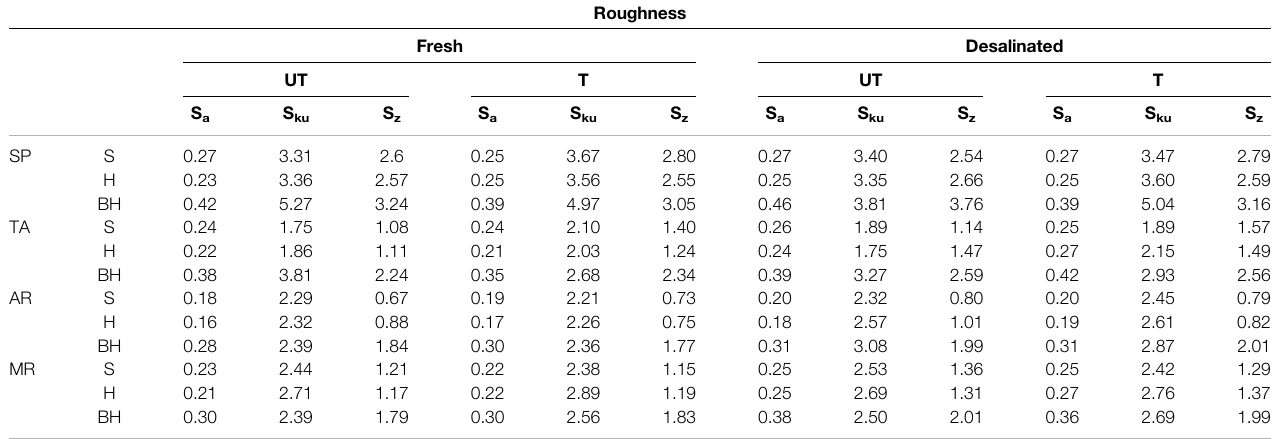
TABLE 2 | Mean roughness values for intact samples (Fresh) and for altered samples from which the gypsum crust has been removed (Desalinated), untreated (UT) and treated (T) in relation to each surface fi nish (saw-cut - S, honed - H and bush-hammered - BH) of Calcarenita de Santa Pudia (SP), Travertino Amarillo (TA), Arenisca Ronda (AR) and Molinaza Roja (MR). Legend: S a , is the arithmetic mean value of the absolute values of the heights within a de fi ned area (in mm); S ku , is the kurtosis value for the surface; S z , is the sum of the maximum peak height and the maximum trough depth within a de fi ned area (in